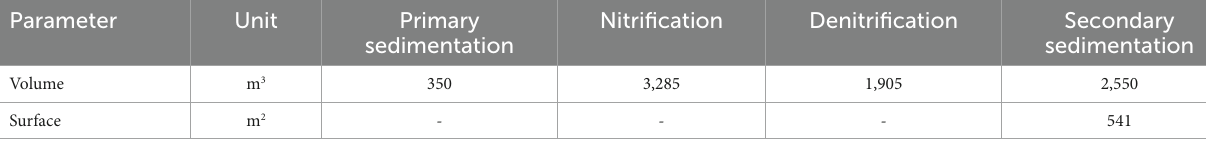
TABLE 4 Characteristics of the treatment stages of conventional MWWTP for 30,000